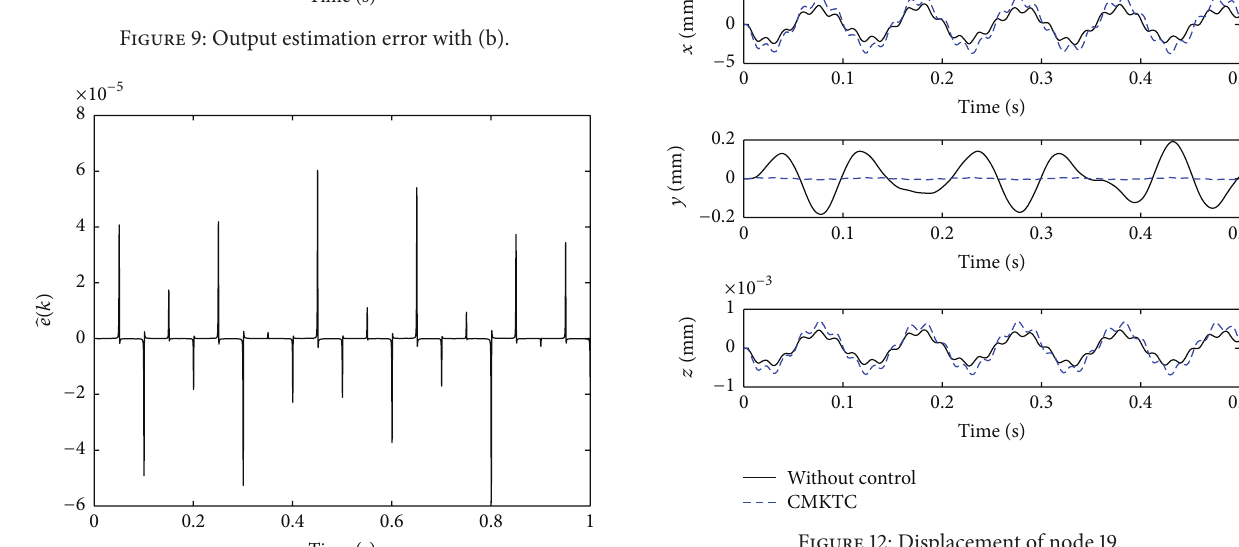
Figure 10: Output estimation error with (c).